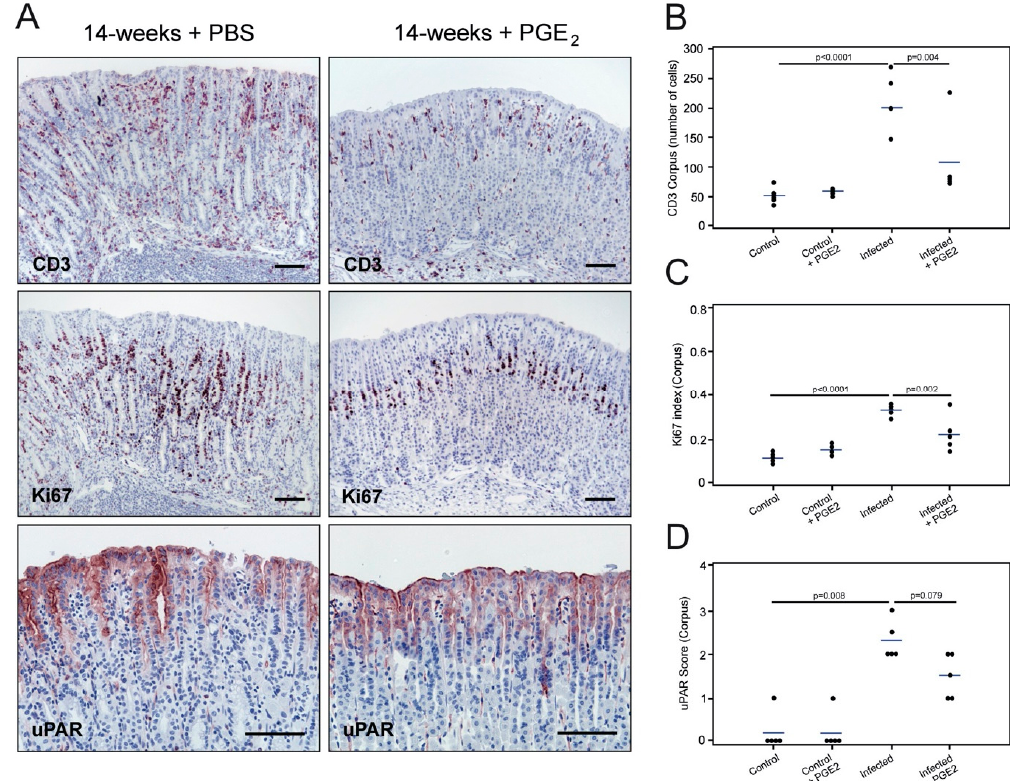
Figure 6. Effect of PGE 2 treatment on uPAR expression in gastric epithelium colonized with H. pylori. Adjacent sections from the gastric mucosa of 14-week H. pylori -inoculated mice treated with saline (PBS) ( A, left column) or with PGE 2 analogs ( A , right column) were processed for immunohistochemistry (CD3, Ki67, and uPAR). Semi-quantitative assessment of infiltrating CD3-positive cells ( B ), cell proliferation activity ( C ), and uPAR staining intensity ( D ) in the corpus region of the mouse stomach for each of the studied groups. One experiment with n = 4–5 mice per experimental group. Scale bars 100 µ